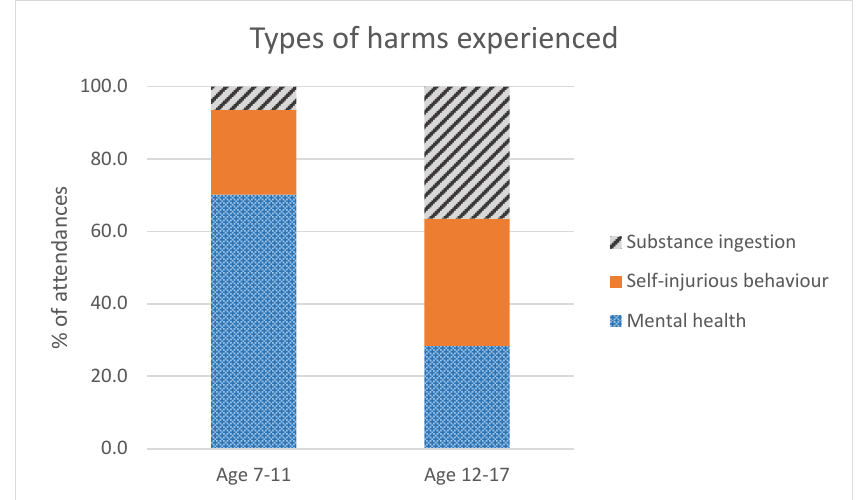
Figure 1. Ambulance attendances as a function of harms experienced. Mental health is the most common outcome experienced by these aged 7–11, followed by self-injurious behaviour and substance ingestion, whereas the inverse of this pattern is seen in those aged 12–17.